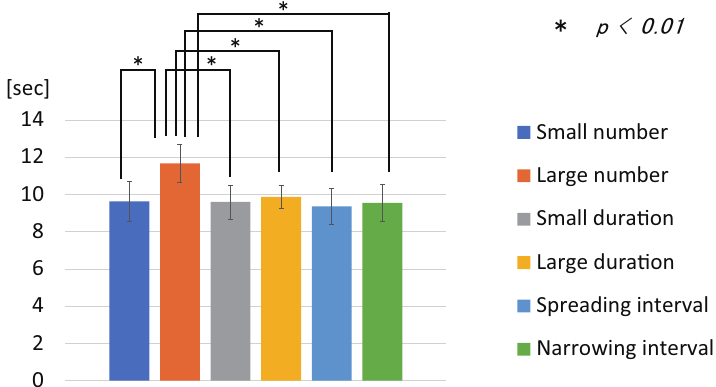
Figure 10. Results of Experiment 4. Scores for each stimulus